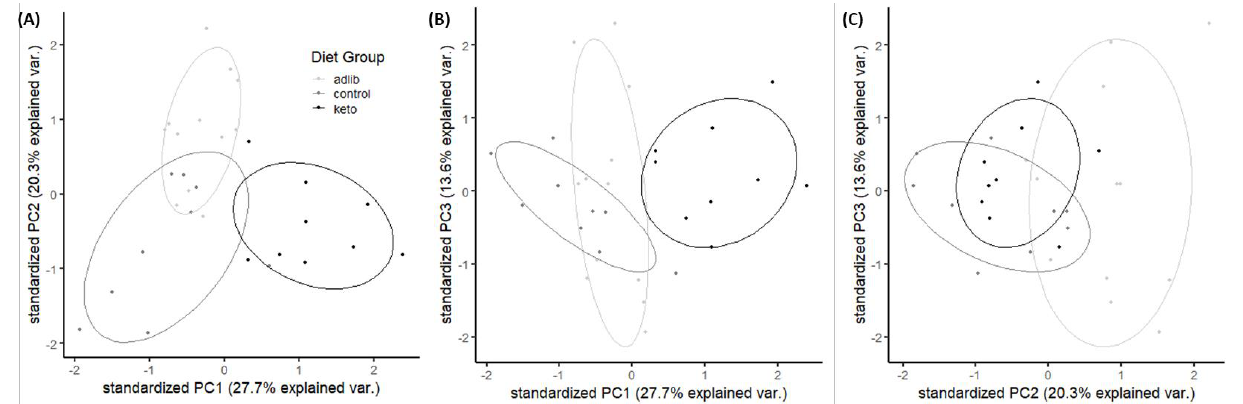
Figure 7. Principal component analysis on measures of nutritional ketosis, cognitive performance and microbiome composition. ( A ) Components 1 and 2, ( B ) components 1 and 3 ( C ) and components 2 and 3 are shown as a function of diet group (light gray = ad libitum fed rats, medium gray = control TRF fed rats and black = ketogenic diet TRF fed rats).